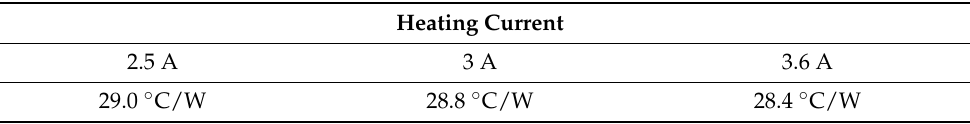
Table 2. Values of Zth evaluated using V ds as